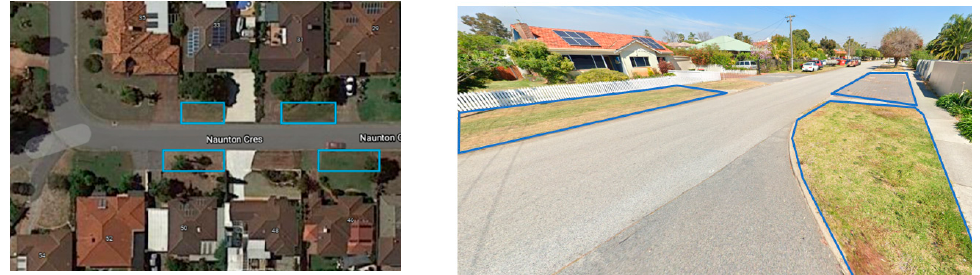
Figure 1. Aerial and horizontal views of residential street verges (collected from Google Maps).